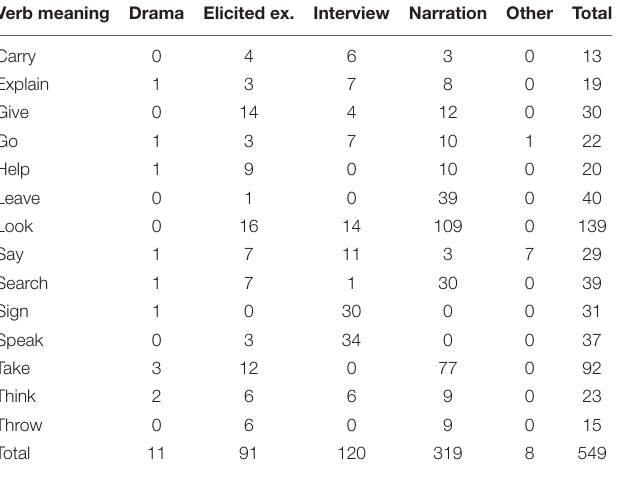
TABLE 2 | Frequency of the selected verb meanings by discourse type.